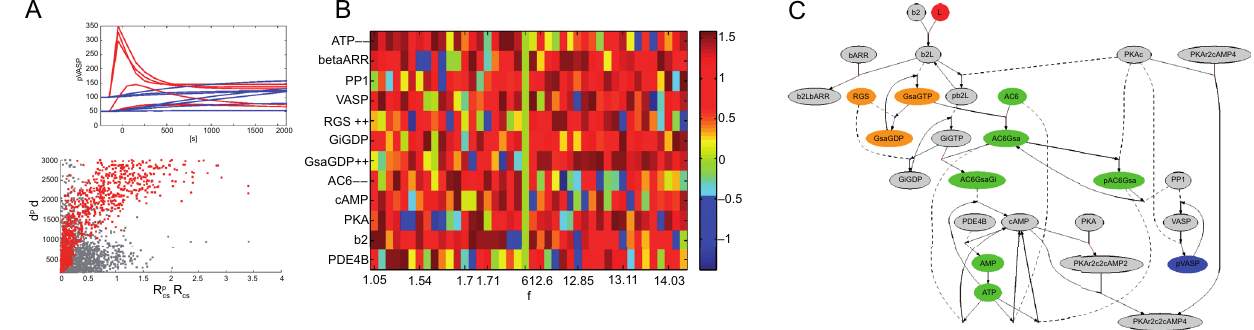
Figure 3. A . (top) Dynamics of selected systems with low ( f (bottom) Distribution of concentration parameters according to d p , R p optimizing for transients, with plateau signaling (left) and strong transients (right), sorted by f green=low) in the biochemical reaction network for a high transient system, as averaged from B . Conforming to intuition, we see that the earlier, driver complex (G-protein) is high for transients, which increase the on-slope for cAMP production.